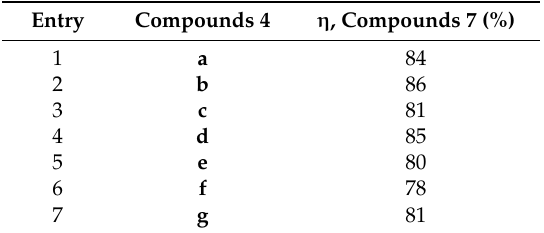
Table 1. Results obtained in the oxidation reactions of 4a – g to 7a – g .